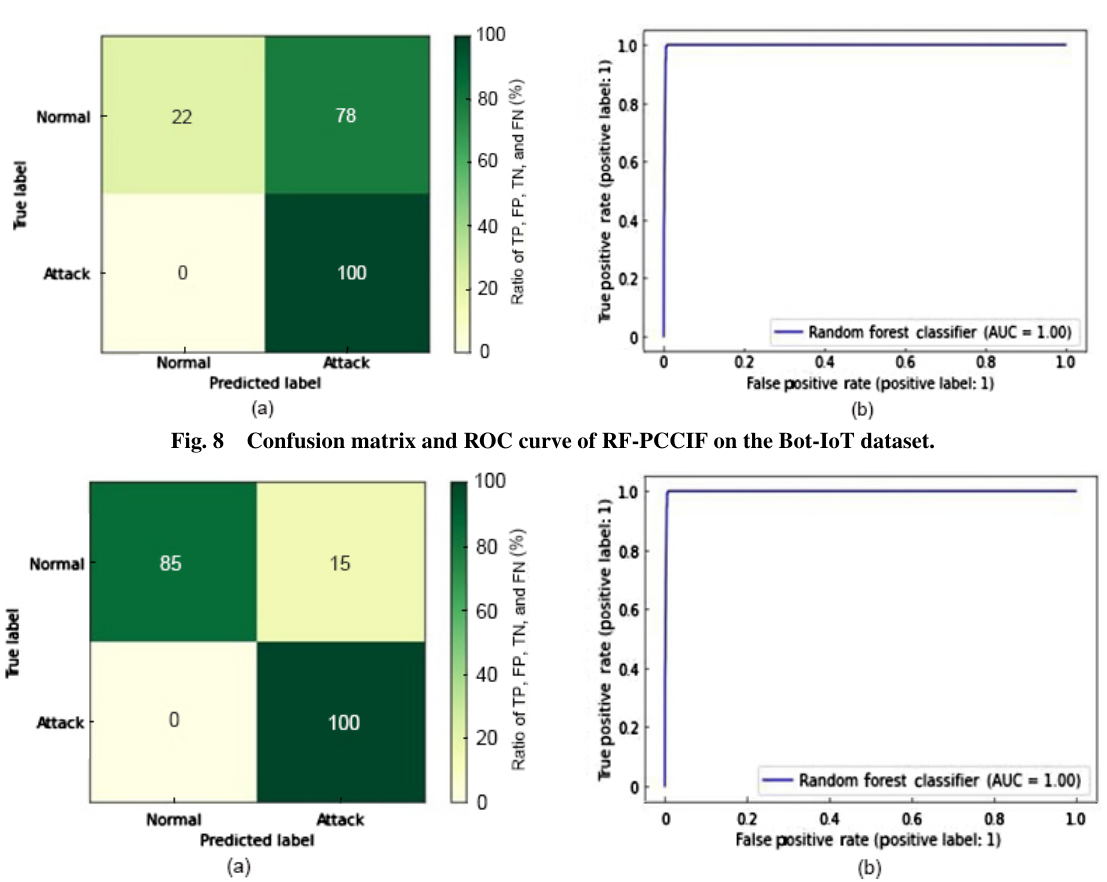
Fig. 9 Confusion matrix and ROC curve of RF-IFPCC on the Bot-IoT